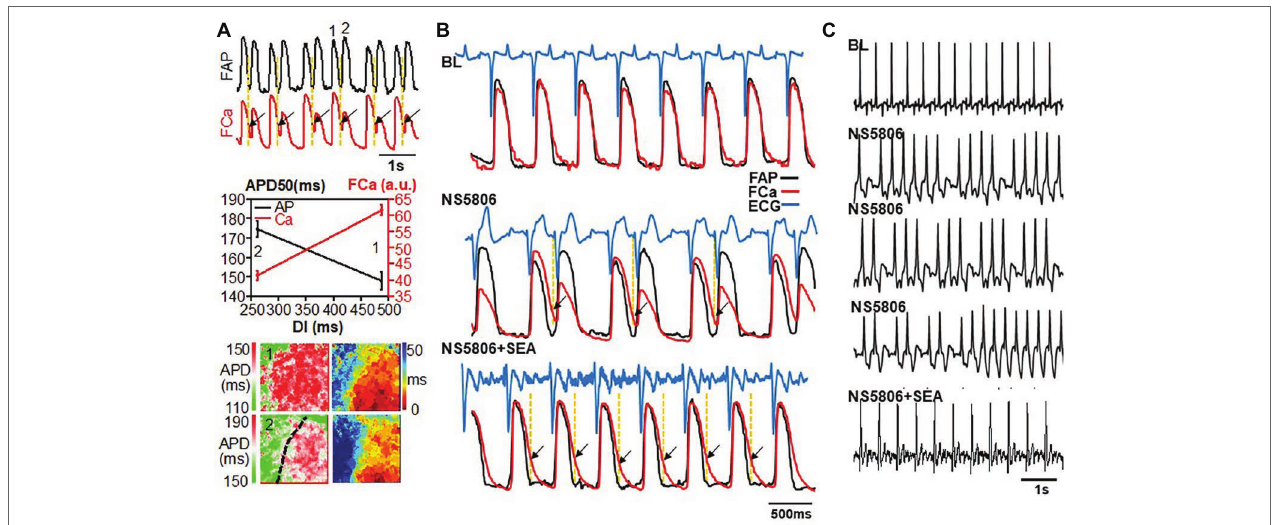
FIGURE 7 | Examples of SEA suppresses NS5806-induced ectopy. (A) NS5806-induced spontaneous PVCs with frequent bigeminy. AP and Ca tracing during NS5806 infusion ( top ), APD and Ca versus DI ( mid ), and APD and isochronal map ( bottom ) for beat 1 and beat 2 as indicated in AP tracing ( top ). Long DIs were followed by short APDs. However, the amplitude of the Ca transient of these beats was consistently large. Ectopic beats initiated at sites in which the Ca transient was still on-going (~30.9% of maximum amplitude) while the AP had already terminated. Dotted line marks location of left anterior descending artery. Of note, APD maps are shown in different time scale to appreciate the spatial distribution with color. (B,C) SEA abolished NS5806-induced ventricular bigeminy and ectopic VT. Arrows indicate the high Ca load sites. Ectopic beats initiated with Ca-driven phase-4 depolarization via NCX. NCX blockade with SEA eliminated phase-4